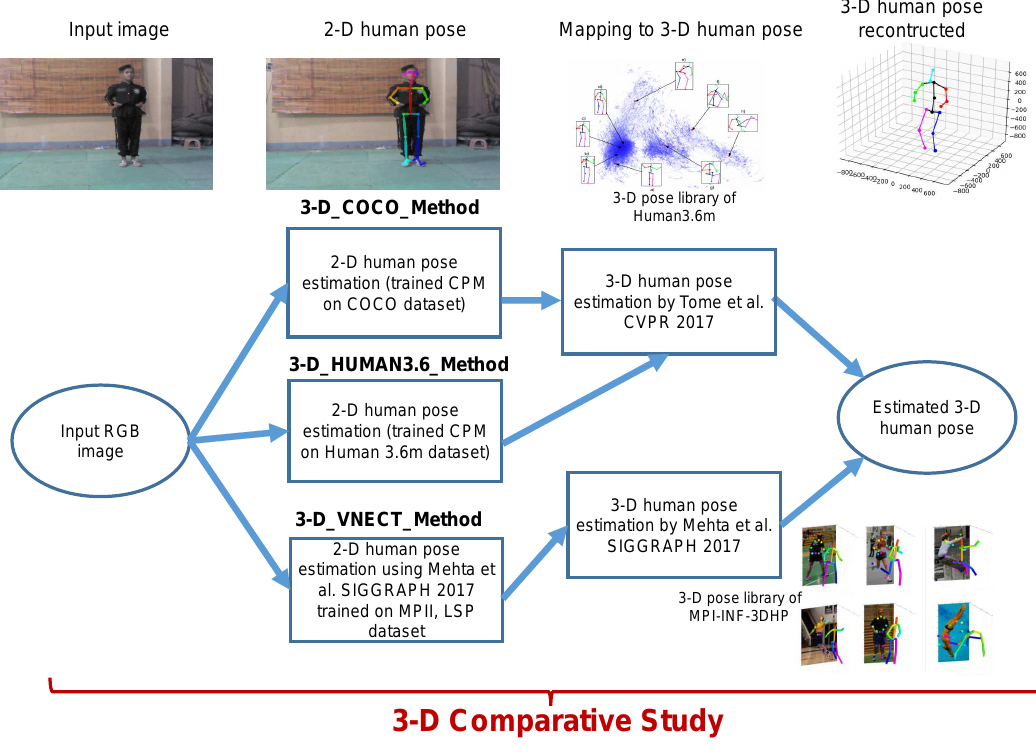
Fig. 6: Comparative study for evaluating 2-D human pose estimation in the 3-D space.